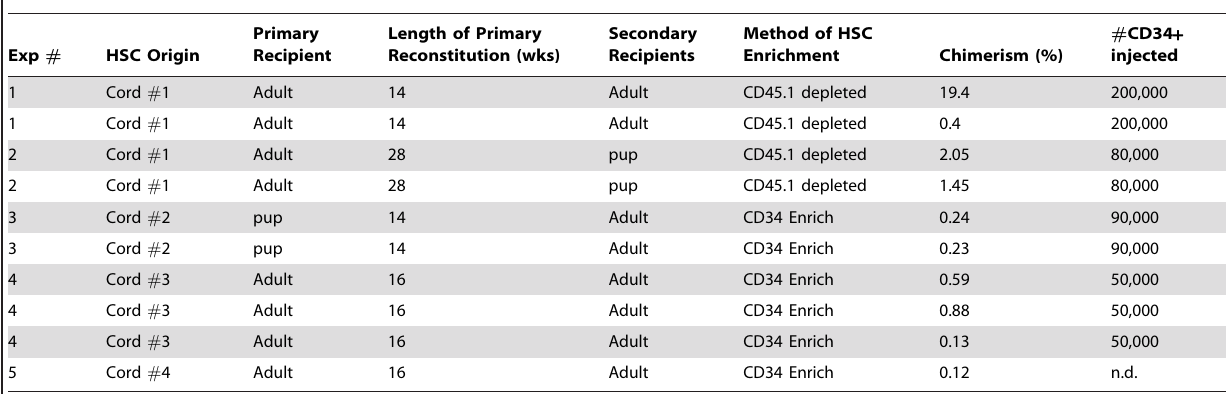
Table 1. Summary of secondary reconstitutions in NSG mice.